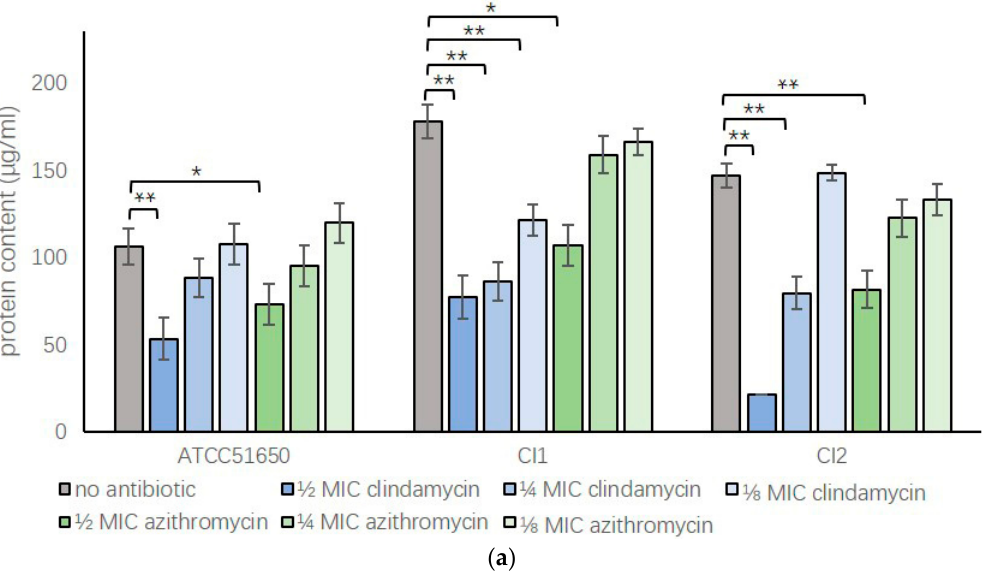
Figure 1. Sub-inhibitory concentrations of clindamycin and azithromycin do not significantly affect bacterial growth following 24 h incubation. The OD600 absorbance values of S. aureus after 24 h culture. ATCC51650, CI1, CI2 were grown without (no antibiotic, grey) or with ½, ¼, ⅛ MIC clindamycin (blue) or azithromycin (green) ( p > 0.05). n = 3, bars represent standard error of means.